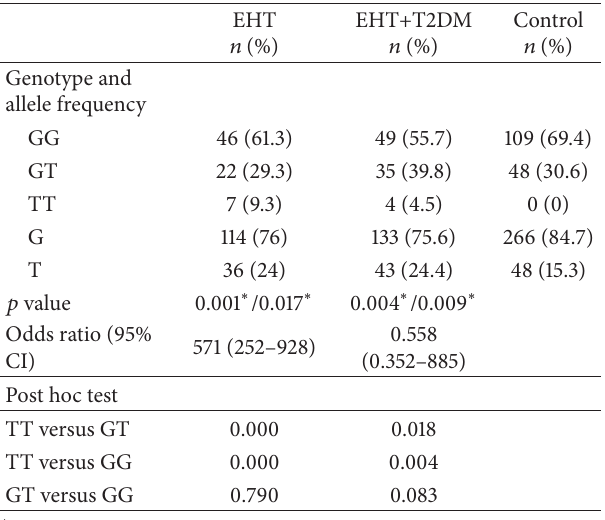
Table 4: Genotypes and allele frequencies distribution of gene polymorphisms between two patient groups and control